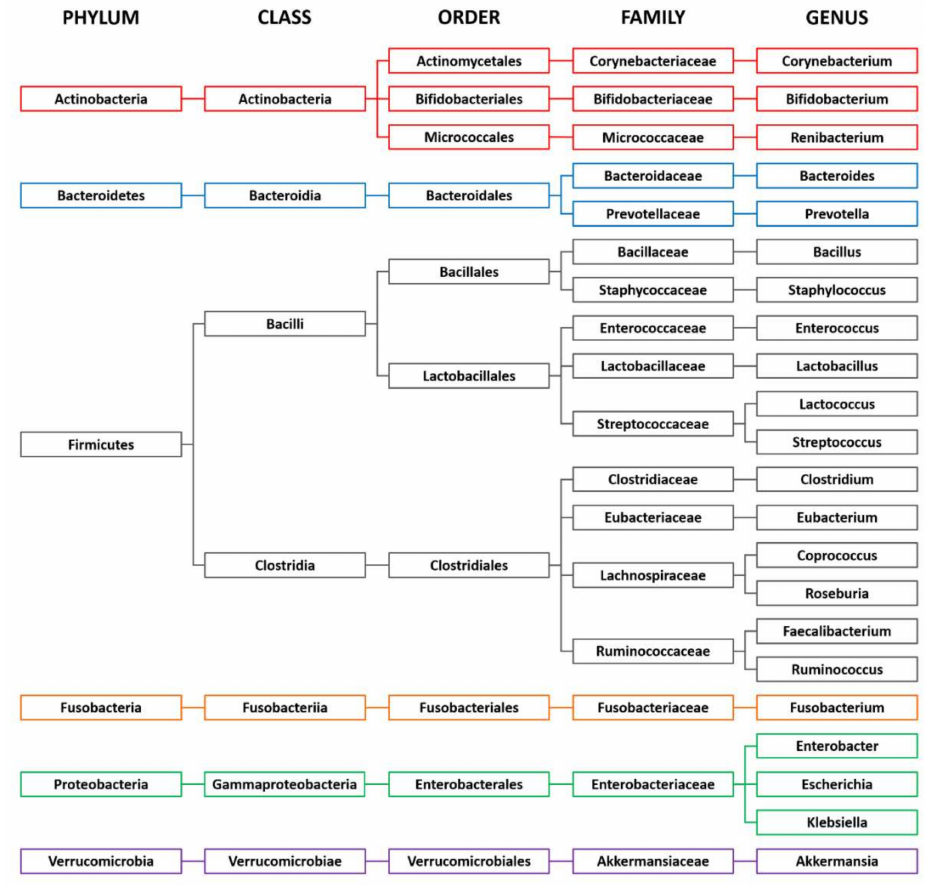
Figure 1. Examples of bacterial taxonomy in the